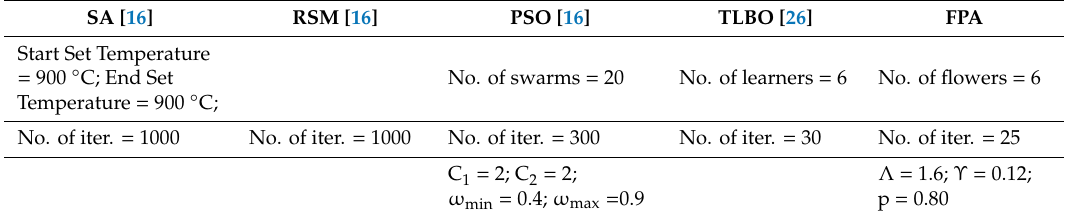
Figure 11. Convergence curve for managing congestion using FPA’. Table 6. Parametric settings proposed FPA with other optimization techniques.